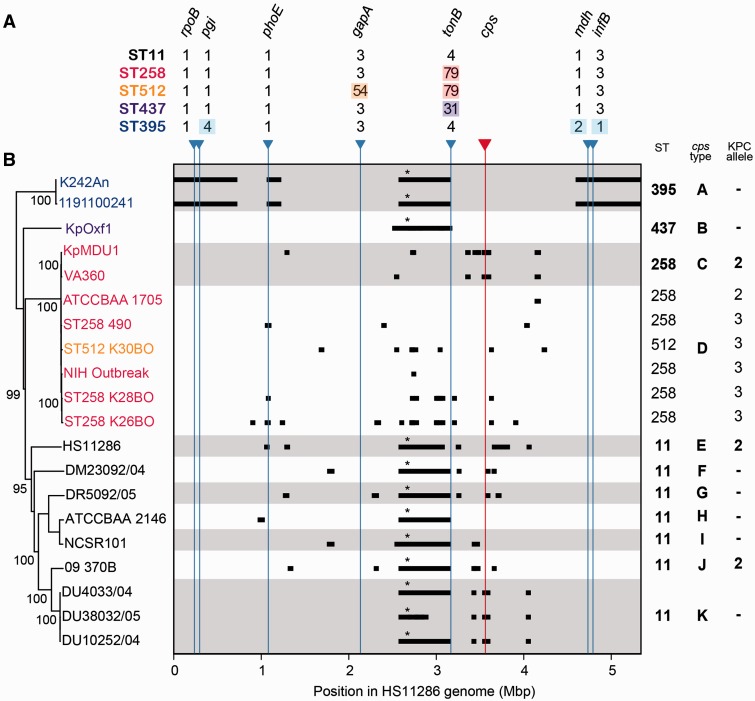
CG258 MLST profiles, genome-wide phylogeny, and putative recombinant genomic regions. Both panels (A and B) share the x-axis, which indicates coordinates of the HS11286 genome (ST11) that was used as the reference for read mapping and SNP calling. Blue arrows indicate the chromosomal positions of MLST loci along this axis; red arrow indicates the position of the cps locus. MLST alleles for the five STs are shown in (A); those differing from ST11 alleles are highlighted. Nucleotide polymorphisms resulting from recombinant genomic imports identified by BRATNextGen are shown as black blocks in (B); these were excluded from phylogenetic analysis (tree in (B), bootstrap support values ≥ 90% are shown (%), strain names colored as per STs in (A) and as marked on the right). A high resolution view of the ST258/512 subclade is shown in supplementary figure S3, Supplementary Material online. Asterisk indicates recombinant imports identified in whole or part in all non-ST258/512 representatives, which ChromoPainter analysis indicated was actually an import into ST258 (supplementary fig. S2, Supplementary Material online). Note that the reference genome is circular and thus what appears here as independent imports at the ends of the K242An and 1191100241 genomes are in fact a single import spanning the origin. Gray and white background shading indicates changes in capsular locus type; types are labeled A–K on the right, genetic structures for these are given in figure 2. STs and KPC alleles are also indicated on the right. Where isolates sharing a cps locus also shared an ST or KPC allele, the ST and/or KPC allele are listed once only for the entire group. Note that the NIH outbreak genomes (n = 20) are all highly similar and represented as a single leaf node for simplicity.